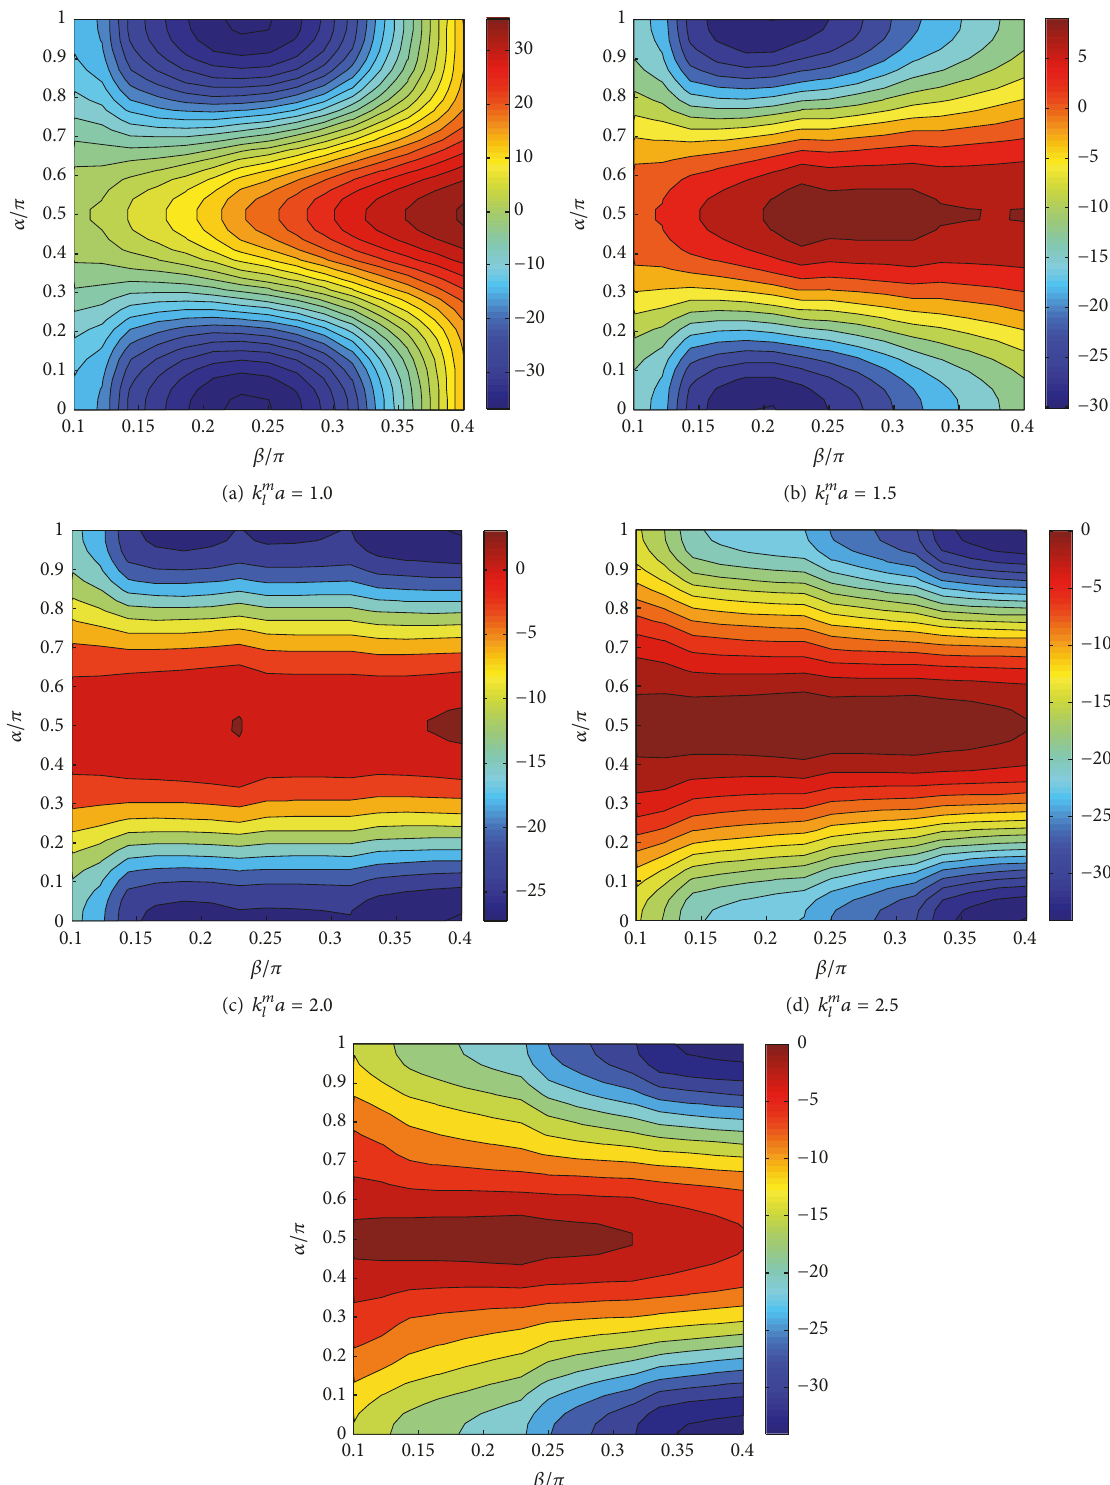
Figure 7: Relative difference (%) of the calculated 𝜎 𝑠 by a fiber with a partially imperfect bonding and with the fully perfect bonding, under the P-wave incidence at several different normalized